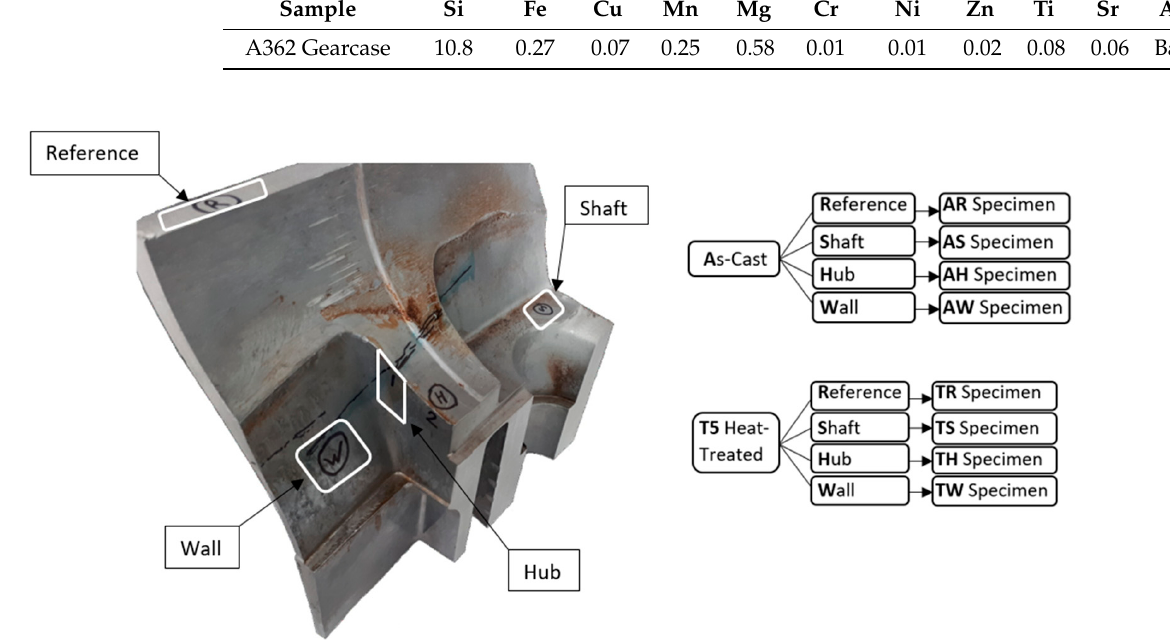
Table 1. The chemical composition (wt.%) of A362 alloy taken from the prototype gearcase. Sample